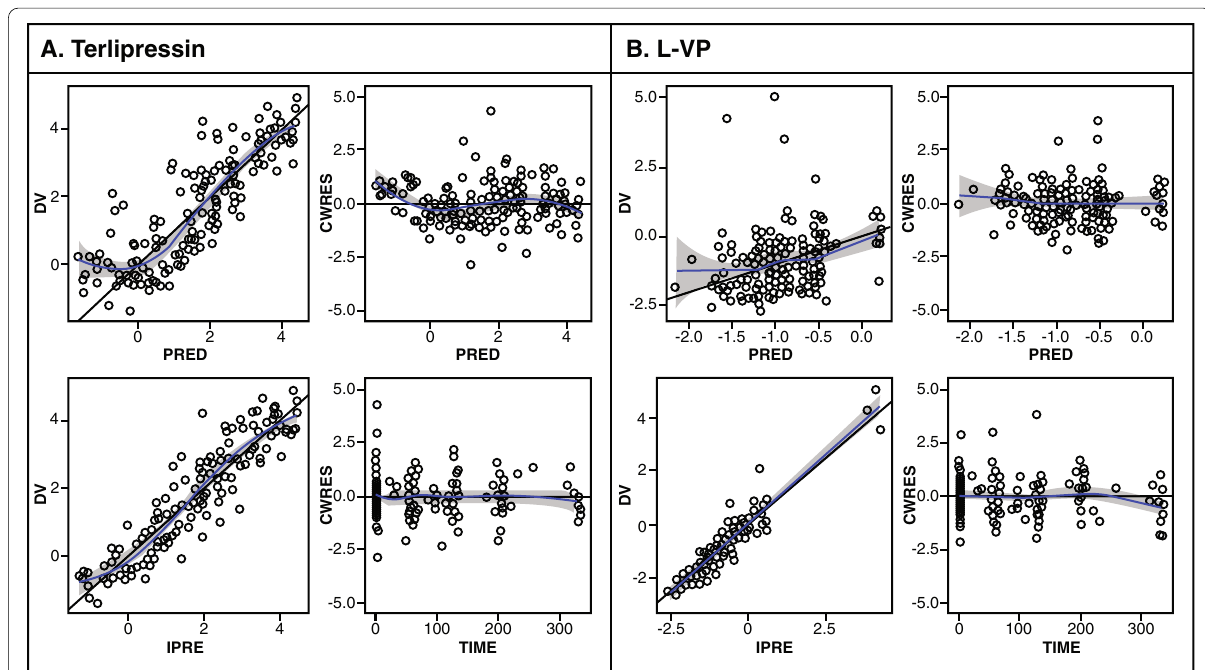
Fig. 2 Goodness-of-fit diagnostic plots of the final model of terlipressin. CWRES , conditional weighted residual value; DV , observed concentration; IPRE , individual predicted value; L-VP , lysine-vasopressin; PRED , typical value. Log transformed observed data used for model development